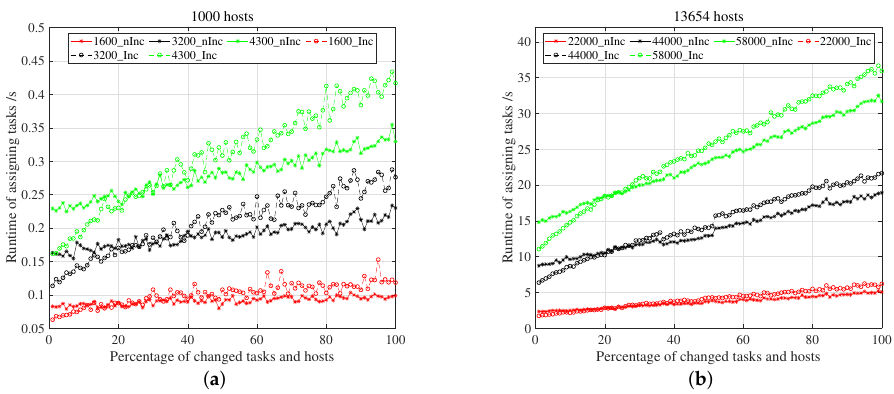
Figure 7. Runtime of assigning tasks based on the generated optimal flow. ( a ) 1000 hosts. ( b ) 13,654 hosts.